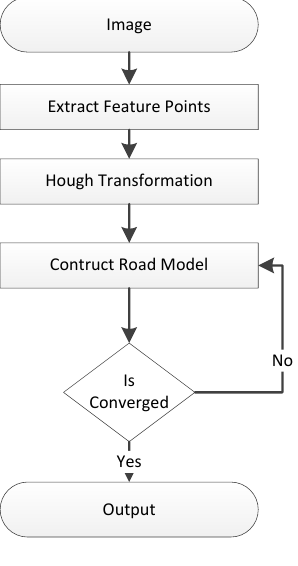
Fig 1. The process of lane detection